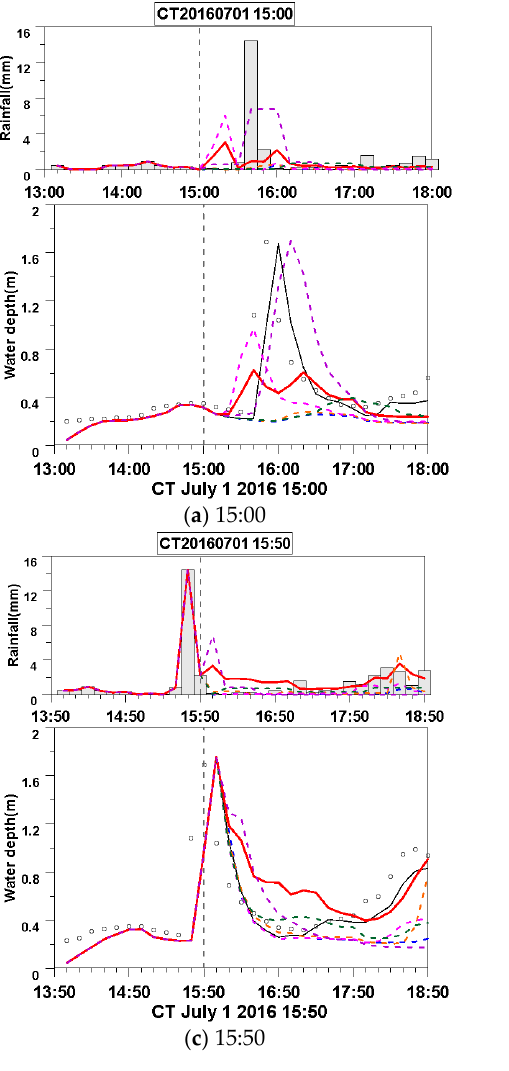
Figure 10 . Comparisons between observed and simulated rainfall data using water depth in pipe at three locations in Gangnam for Case 1 (July 1, 2016) over time. Upper graphs are the mean area precipitation forecasted by each QPF (lines) and the actual AWS data (grey bars). Lower graphs are simulated (lines) and observed (circles) water depth in pipe. Vertical grey lines mark the current time of each subfigure. (a) 15:00; (b) 15:30; (c) 15:50